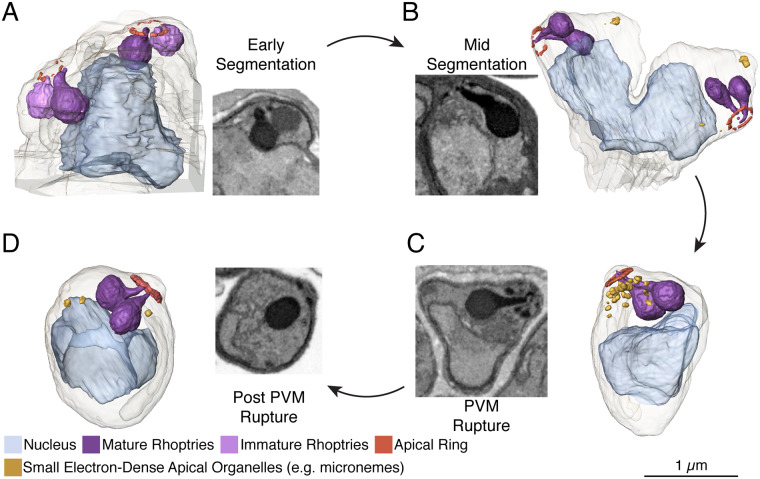
Apical end development throughout schizogony.A. Apical end of a 2n nucleus in early segmentation. At this stage, the apical ring is not well-defined, resulting in fragmented rendering. Each pair of rhoptries has a mature, electron-dense bulb, and a less mature, less electron-dense bulb, visible in the electron micrograph inset and rendered in darker and lighter shades of purple, respectively. B. At mid-segmentation, the apical ring is more defined and both rhoptries in each set are mature. A few small, electron-dense apical organelles begin to appear. C. At PVM rupture, the apical head of the parasite is mature, with a well-defined apical ring, multiple small electron-dense organelles, and mature rhoptries. D. Post-PVM rupture, fewer apical organelles remain, presumably due to discharge of a subset of microneme-related organelles, but the defined apical ring and rhoptries are not materially different from the PVM rupture schizont. The three apical polar rings are visible in electron micrographs for each daughter cell, but the first two are too thin to be rendered. Electron micrograph insets for A-C do not correspond to the rendered apical head. Scale bars of renderings interpolated from structure sizes in EM data.